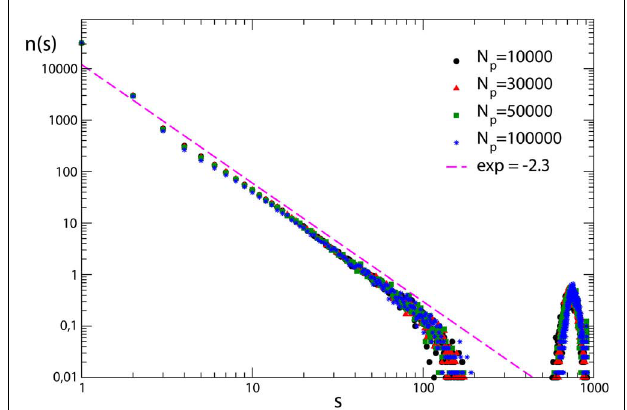
FIGURE 6 |Avalanche size distribution for 100 configurations of fully connected networks with N = 1000 neurons with p in = 0.05. The different curves correspond to different durations of the plastic adaptation period N p